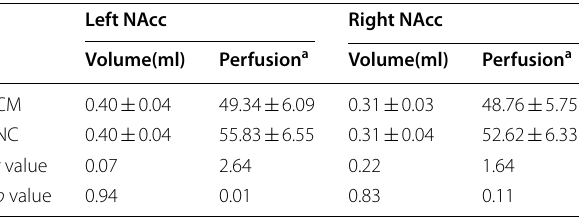
Table 1 Comparison of the volume and perfusion of NAcc between CM and NC